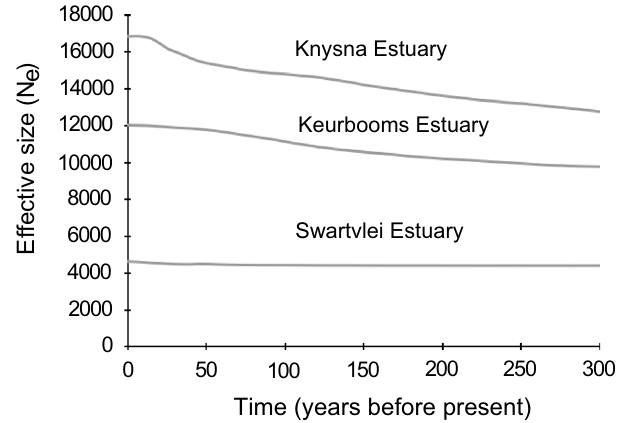
Figure 3. Extended Bayesian Skyline plot (EBSP) showing long-term trends in effective population size of the three populations of the Knysna